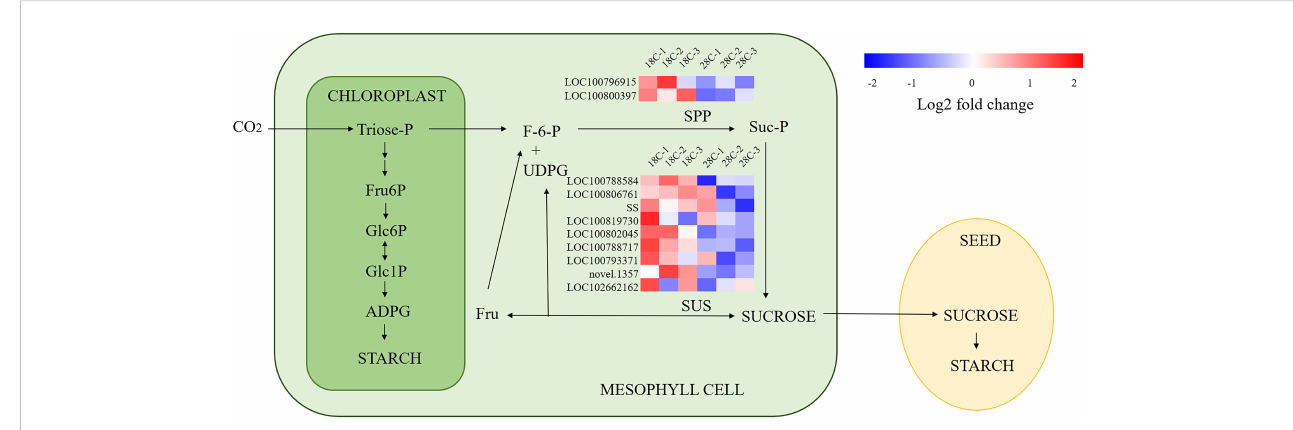
FIGURE 8 A simpli fi ed version of the starch and sucrose metabolic pathway. Heat map indicates the Differential Expression Genes (DEGs) associated to the starch and sucrose metabolic pathway. Red indicates up-regulated genes, and blue indicates down-regulated genes. The pathway is modi fi ed from a fi gure in ref (Fünfgeld et al., 2022).